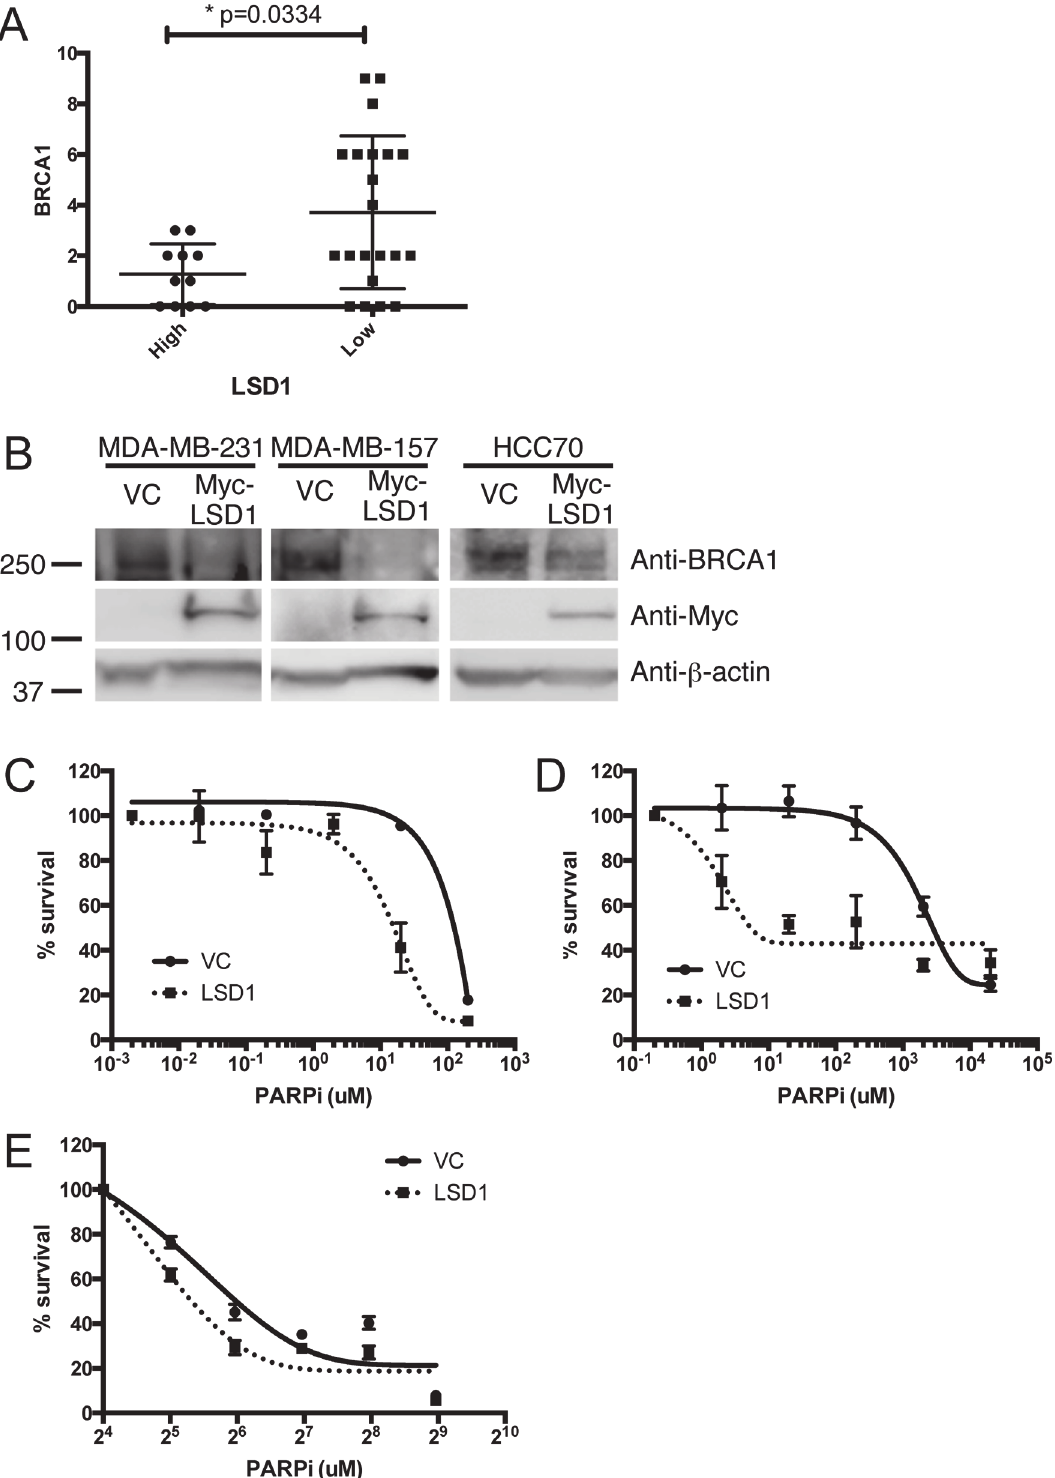
Fig 4. Overexpression of LSD1 reduces BRCA1 expression in triple negative or in basal-like breast cancer and increases sensitivity to PARP inhibitor in basal-like breast cancer. Histogram shows protein expression of BRCA1 in triple negative breast cancer with high or low level of LSD1 protein (A). Y-axis indicates IHC score of BRCA1. Basal-like breast cancer cell lines (MDA-MB-231, MDA-MB-157 and HCC70) was transfected as indicated. Cell lysates were subjected for Western Blots with indicated antibodies (B). Cell viability of basal-like breast cancer cell lines are assessed by colony formation assay. Percent survival is shown in different doses of PARP inhibitor. Error bars show standard deviation of three independent experiments (C-E). doi:10.1371/journal.pone.0118002.g004 PLOS ONE | DOI:10.1371/journal.pone.0118002 February 13,